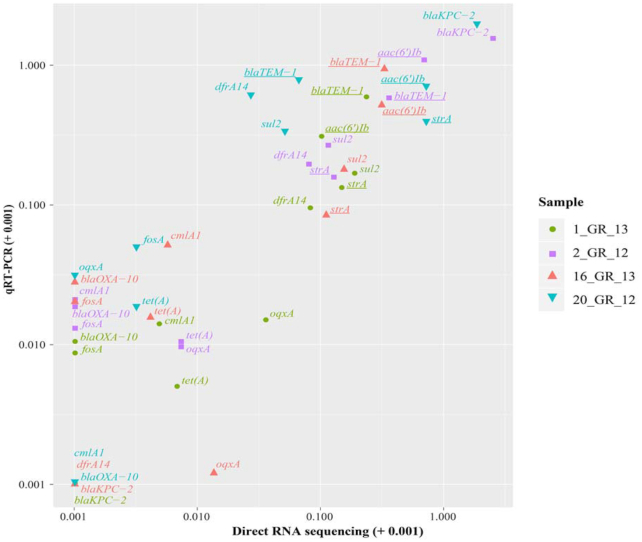
Correlation between resistance genes detected via direct RNA sequencing and validated using qRT-PCR. Relative expression was calculated via normalizing to the housekeeping gene, rpsL, for both direct RNA sequencing (log2(gene/rpsL)) and qRT-PCT (2−(gene/rpsL)). Owing to high similarity between certain genes, several primers recognize >1 gene (underlined). These include aac(6’)Ib: aac(6’)Ib-cr, aadA24; strA: aph(3'')-Ib, and blaTEM-1: blaTEM-1A, blaTEM-1B. Values are log10 transformed and shifted +0.001 to display genes with no detectable expression.